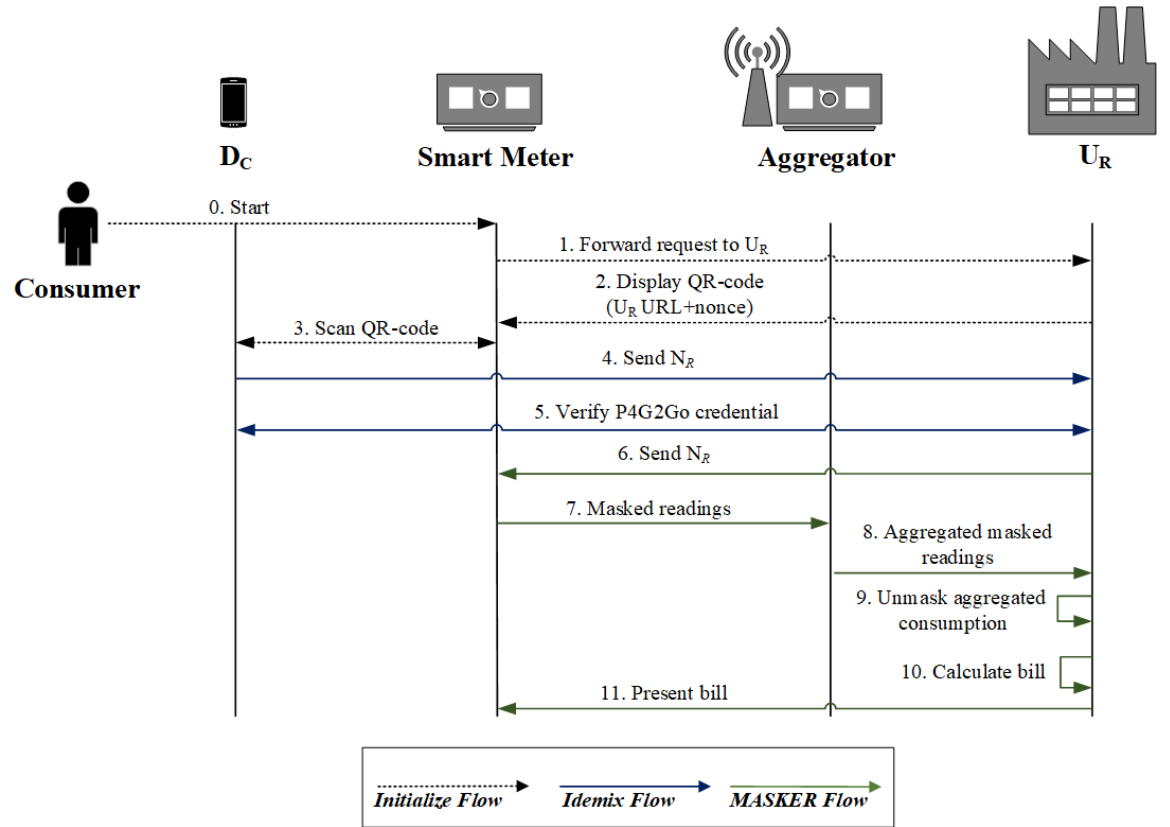
Figure 4. P4G2Go credential verification and energy consumption.